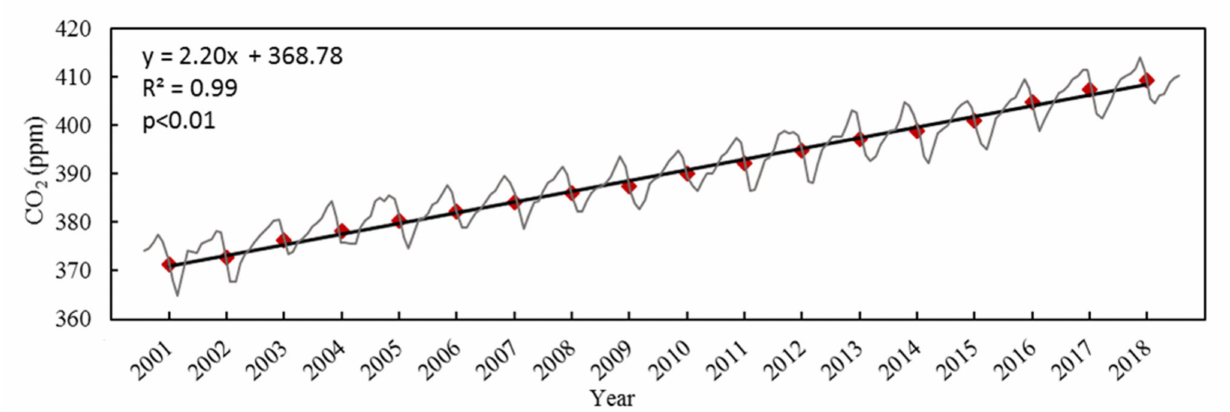
Figure 10. Curve of CO 2 observation value at Waliguan station from 2001 to 2018. The gray curve represents the monthly mean value of CO 2 , the red dot represents the annual mean value of CO 2 , and the black line represents the change trend of annual mean CO 2